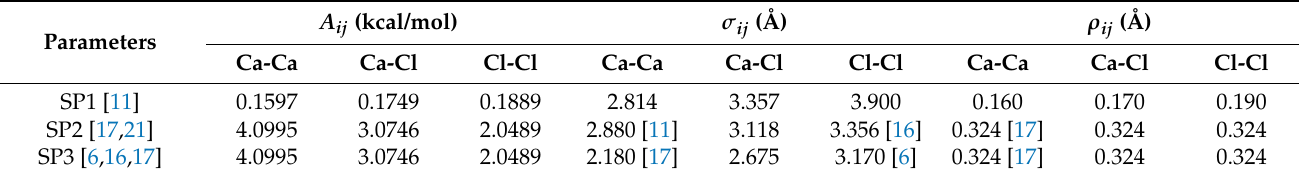
Table 1. Born-Mayer-Huggins potential parameters of CaCl 2